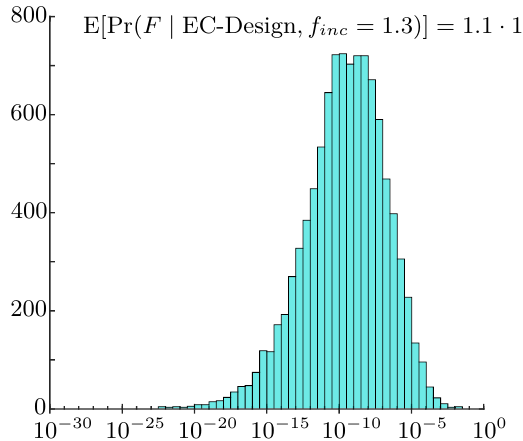
Figure 4. Histogram of the probability of failure Pr( F EC-Design , f inc = 1 . 3) of bridge structures | designed following Eurocode loaded by a 30 % higher traffic load.